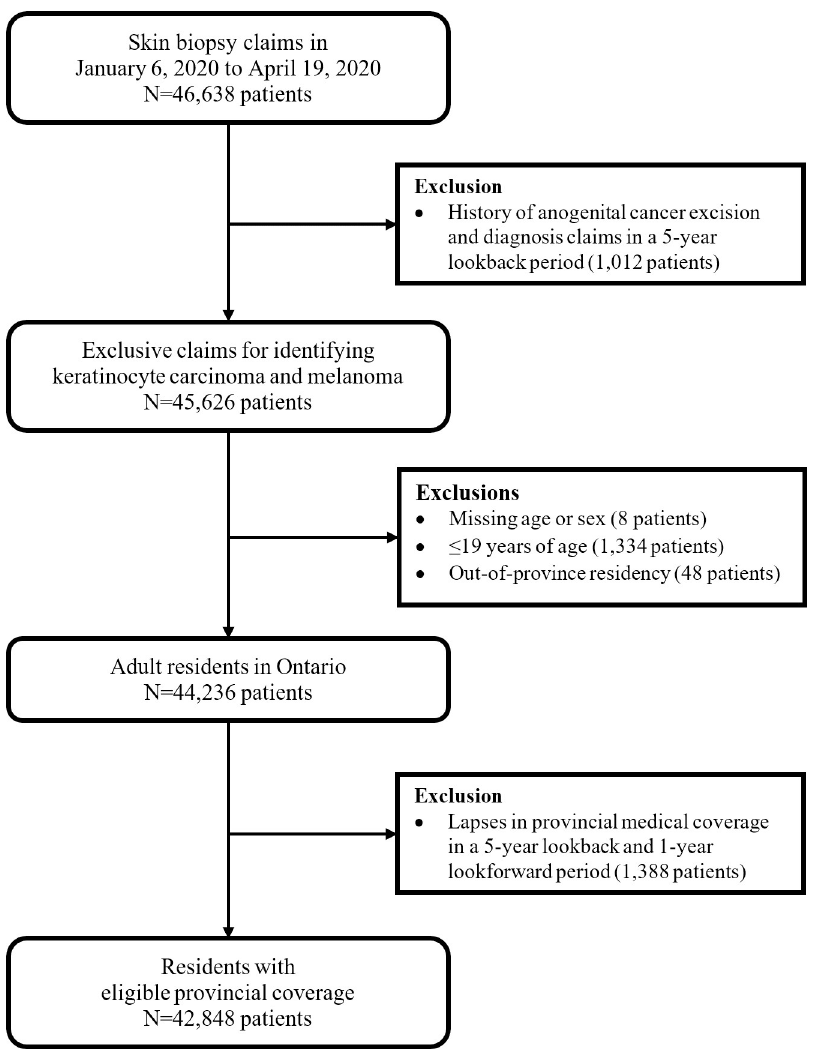
Fig 1. Flow diagram for selection of study cohort of skin biopsy claims from January 6, 2020 to April 19,